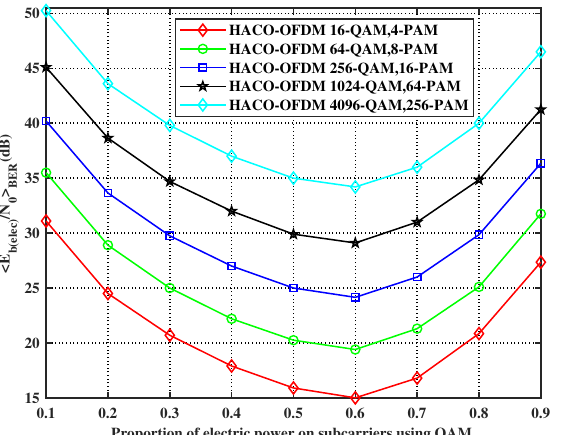
Figure 6. Comparison of (cid:104) E b ( elec ) / N 0 (cid:105) BER for HACO-OFDM for different proportions of elec- tric power.